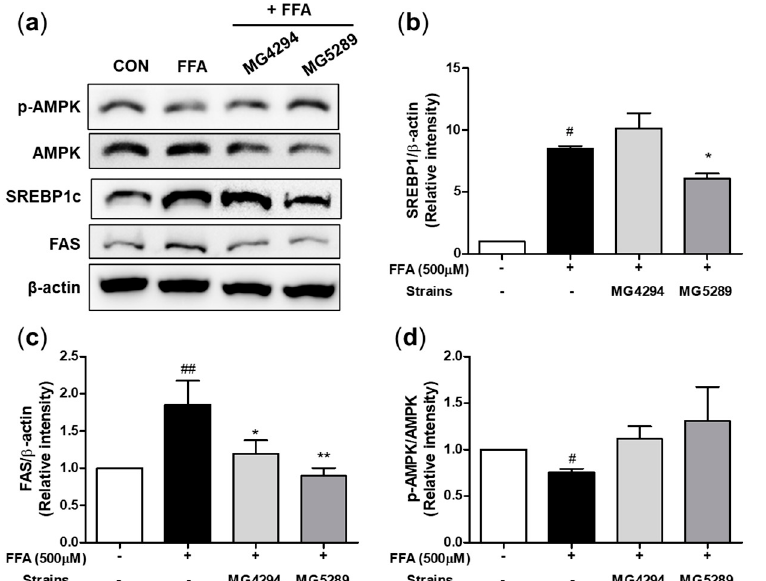
Figure 3. E ff ects of L. fermentum MG4294 and L. plantarum MG5289 on lipid metabolism in FFA- induced HepG2 cells. The representative blo tt ing images ( a ) and protein expression levels of SREBP1c ( b ), FAS ( c ), and p-AMPK/AMPK ( d ) were analyzed via Western blo tt ing. The β -actin and AMPK were used as loading control. The data are expressed as mean ± SEM ( n = 3). # p < 0.05 and ## p < 0.01 compared with control; * p < 0.05 and ** p < 0.01 compared with FFA-induced control.